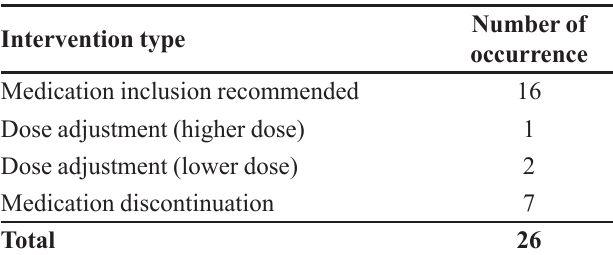
TABLE II - Pharmaceutical Interventions, Niteroi, 2012,